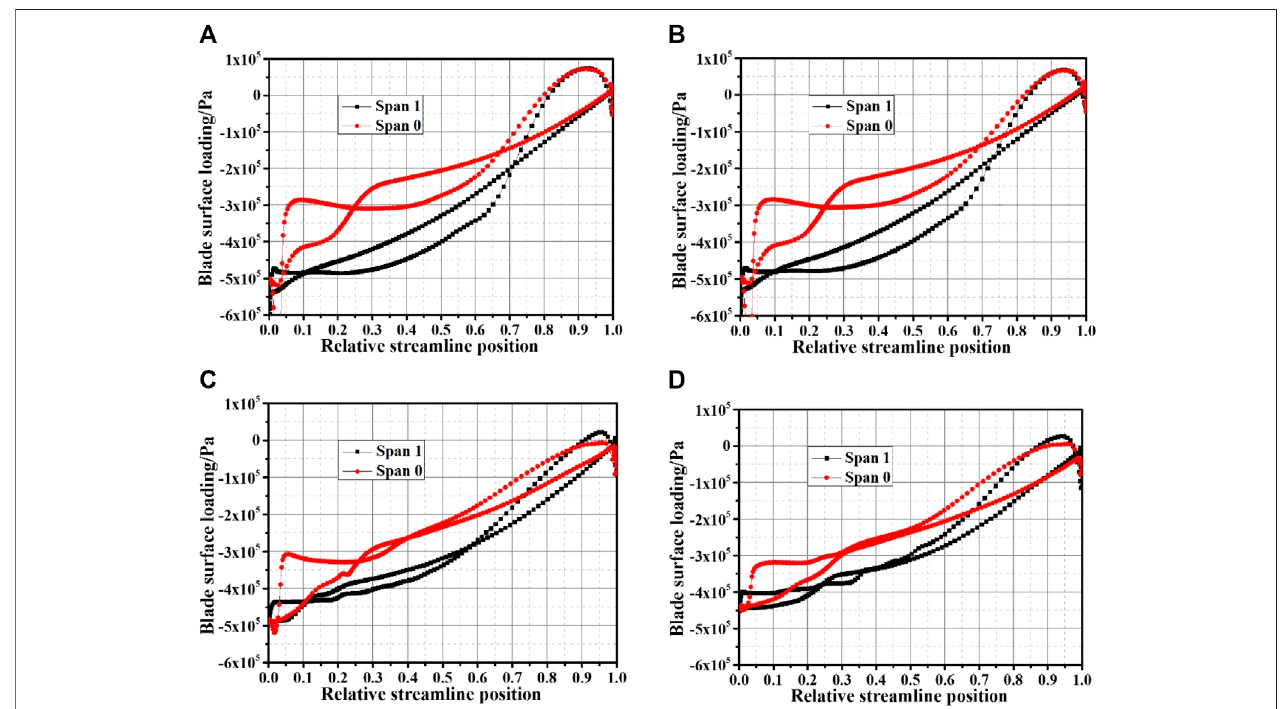
FIGURE 8 | The blade loading with different schemes. (A) Scheme 1. (B) Scheme 2. (C) Scheme 3. (D) Scheme